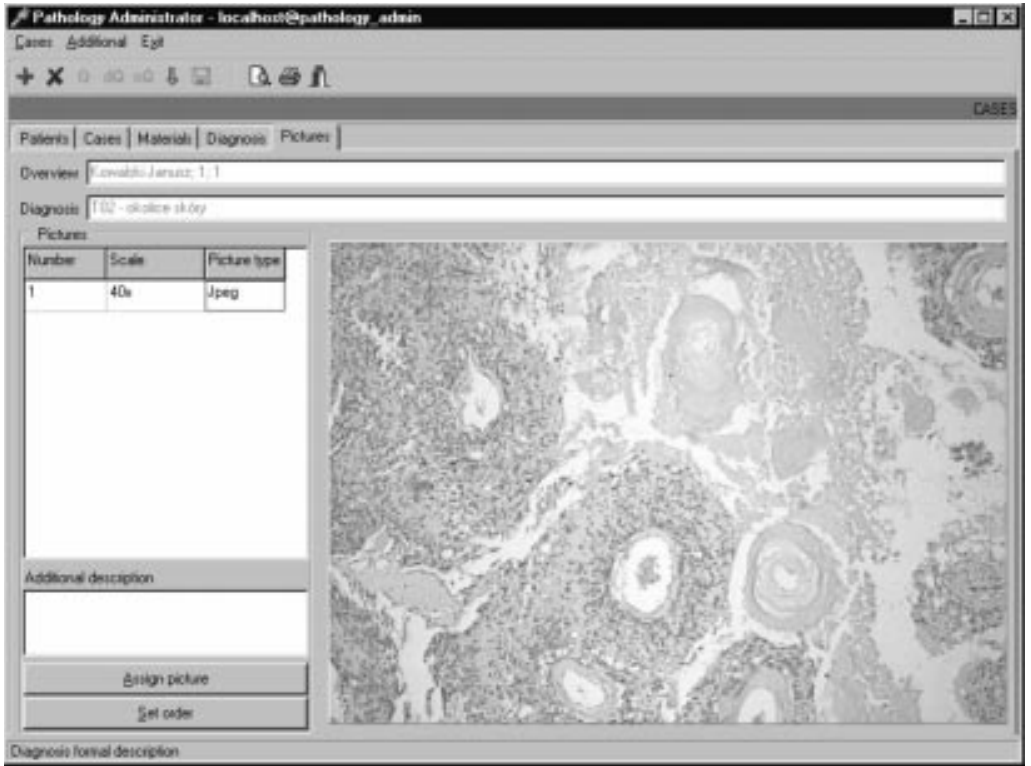
Fig. 1. Screen of data base of text and image files for the construction of virtual case. Management system is based on MySQL, HTTP and PHP